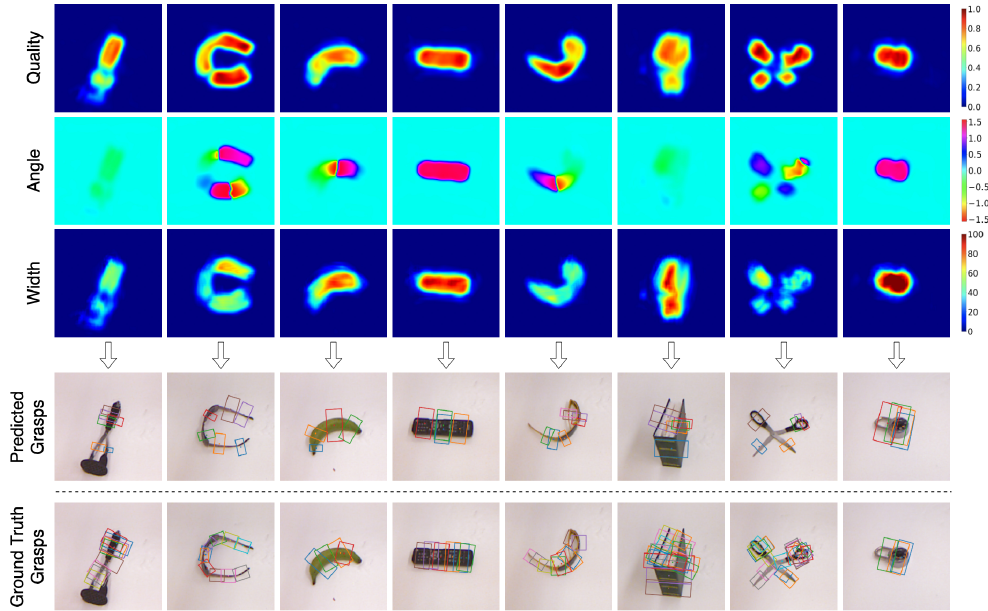
Figure 7. Qualitative results on Cornell Grasping Dataset. The top three rows (quality, angle and width) are the output of GR-Convnet. The bottom two rows are the predicted and ground truth grasps in rectangle grasp representation.